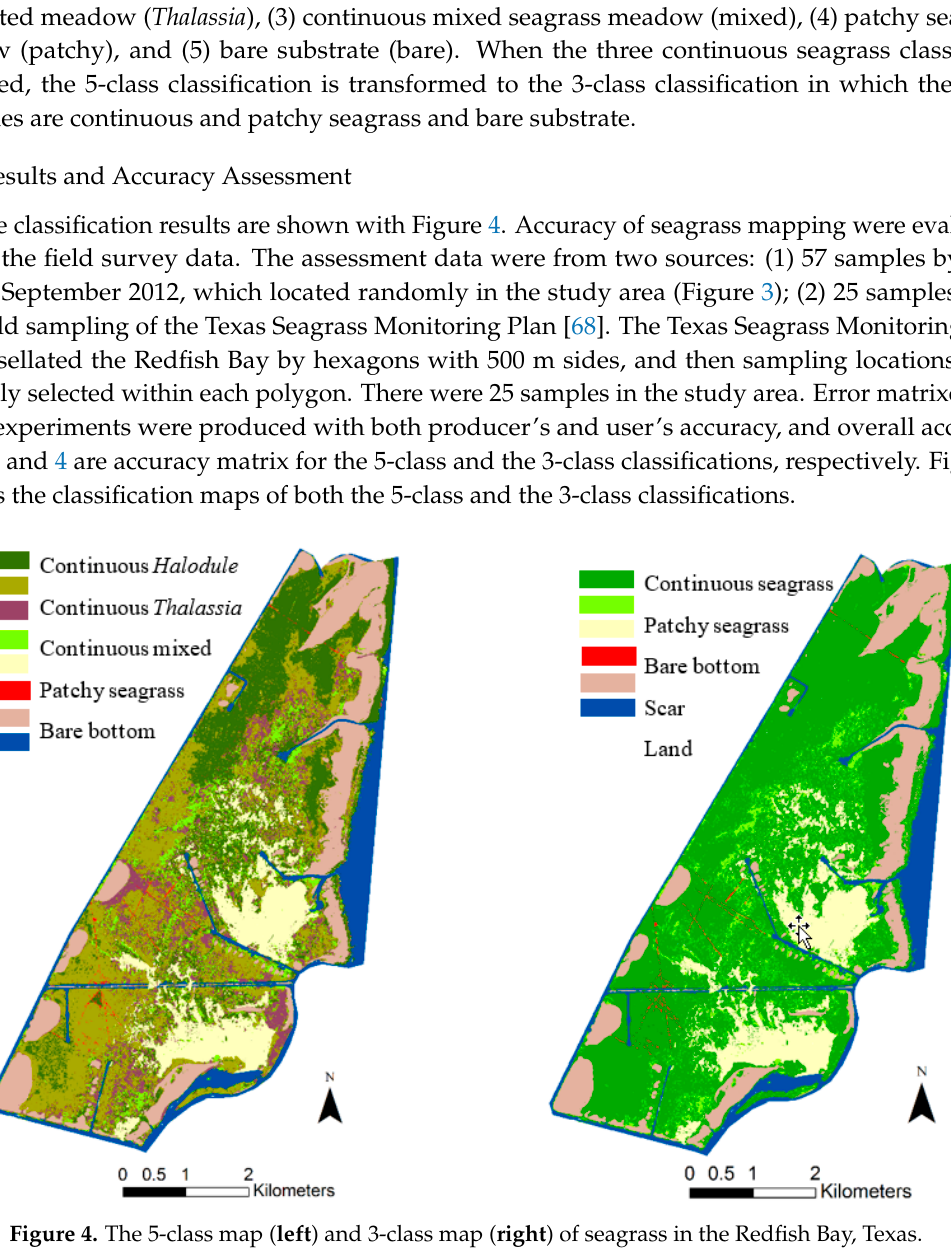
Table 3. Accuracy Matrix of the 5-class classification.